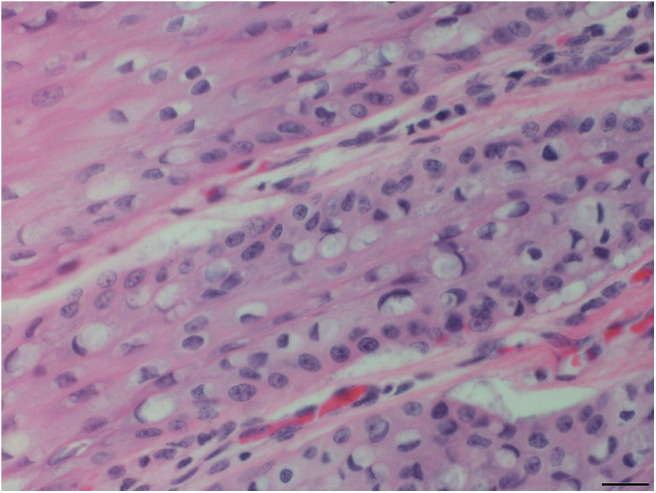
Tongue mucosal plaque, rough-toothed dolphin (case R305). Suprabasilar epithelial cells have perinuclear cytoplasmic vacuolation, with hyperchromatic marginated nuclei and amphophilic intracytoplasmic inclusion bodies (HE). Obj. 40x. Bar = 20 μm.